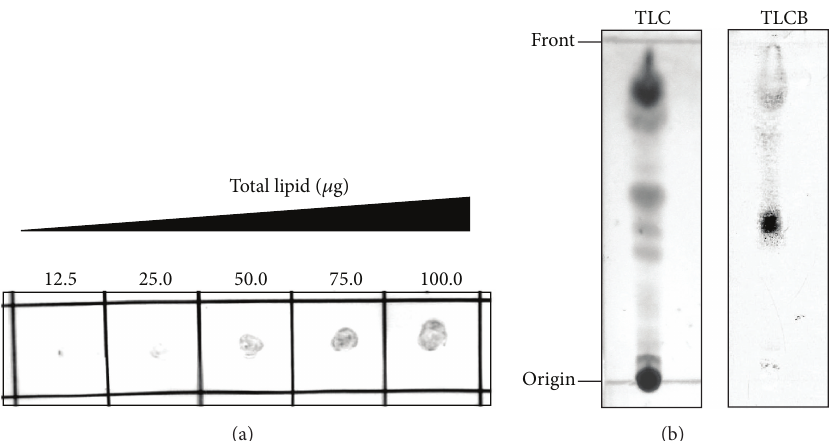
Figure 2: Interaction between lipids of M. avium and HDL. (a) The lipids extracted from M. avium were spotted in the indicated amount (12.5–100.0 𝜇 g) on a nitrocellulose membrane. The membrane was then incubated with HDL (50 𝜇 g protein/mL), and HDL bound to the lipids was visualized using an anti-apoA-I antibody. (b) TLC plates with the spotted lipids (150 𝜇 g each sample) extracted from M. avium were developed using CHCl 3 /CH 3 OH (95: 5, v/v). One plate was treated with a 20% H 2 SO 4 solution to visualize the fractionated lipids (TLC). The fractionated lipids on the other plate were thermally transferred onto a PVDF membrane, which was then incubated with HDL (83 𝜇 g protein/mL). The lipid that bound to HDL was visualized using an anti-apoA-I antibody (TLCB).